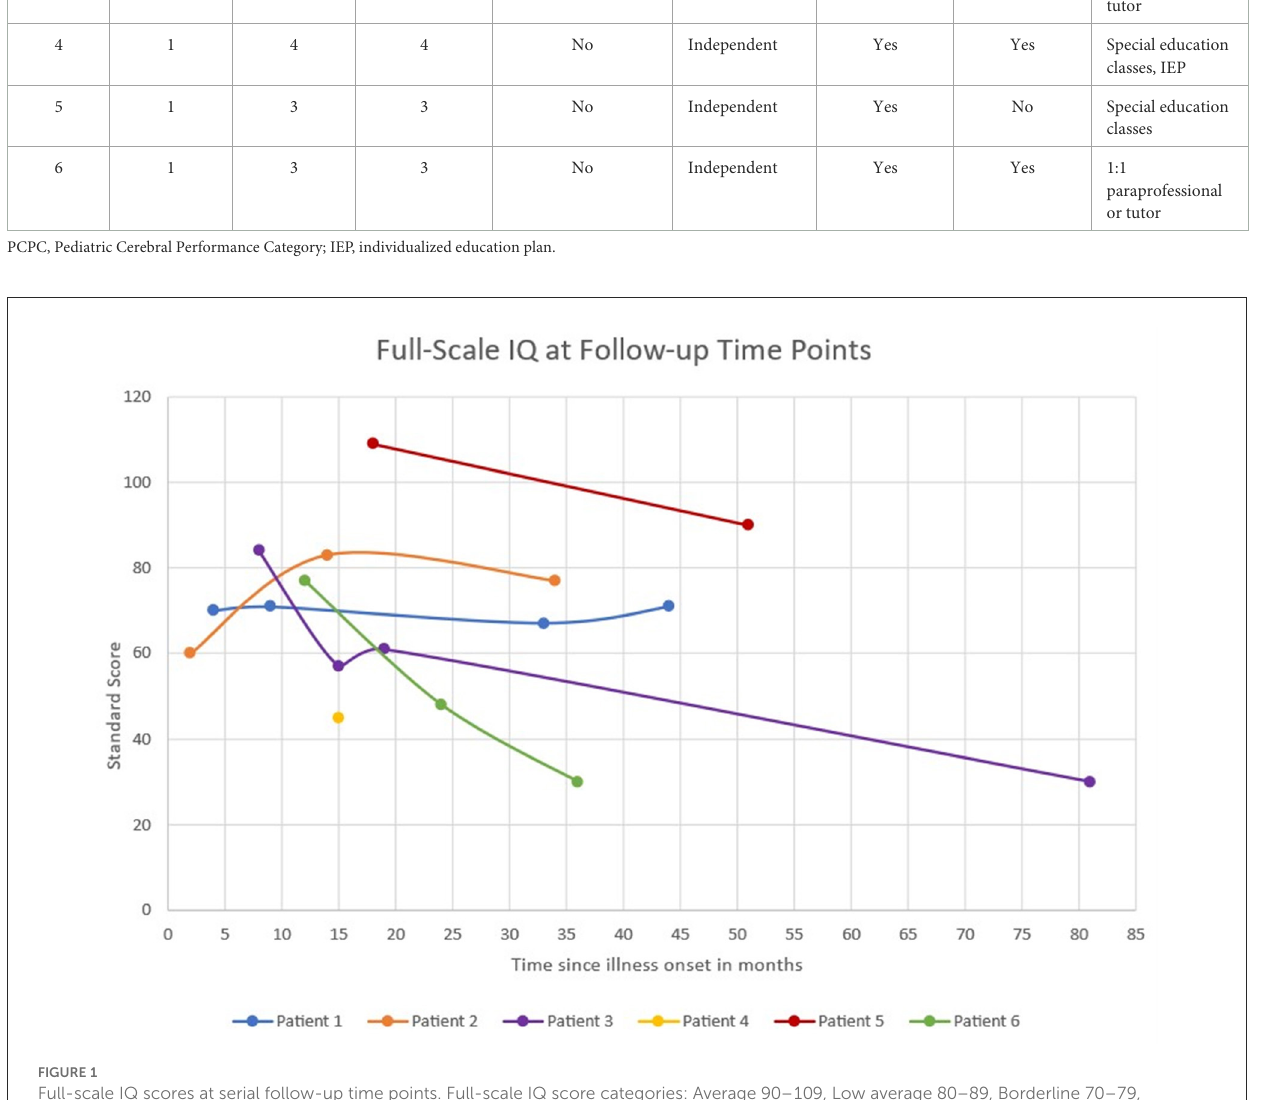
epilepsy and reduced impulse-inhibition in patients with temporal lobe epilepsy (22). These findings and those in the present case series may be in part due to ongoing drug-resistant epilepsy, localization of seizure onset, and cerebral dysfunction in the chronic phase of FIRES with multiple daily antiseizure